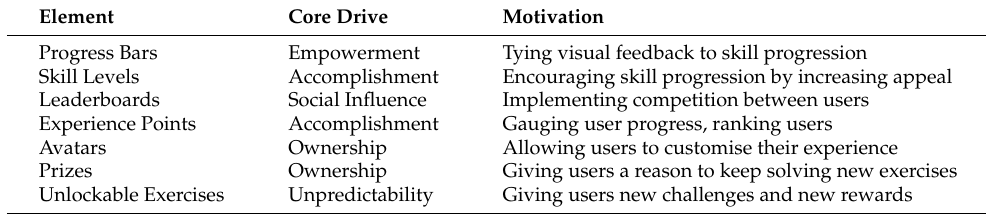
Table 1. Game elements present in